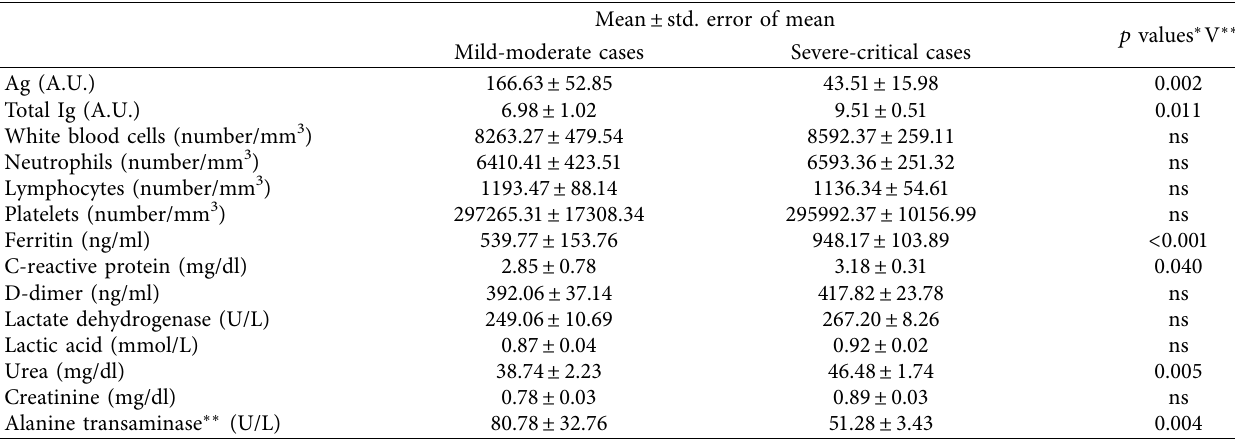
Table 2: Descriptive statistics of the SARS-CoV-2 and host-associated variables that were serially measured in this study. Mean ± std. error of